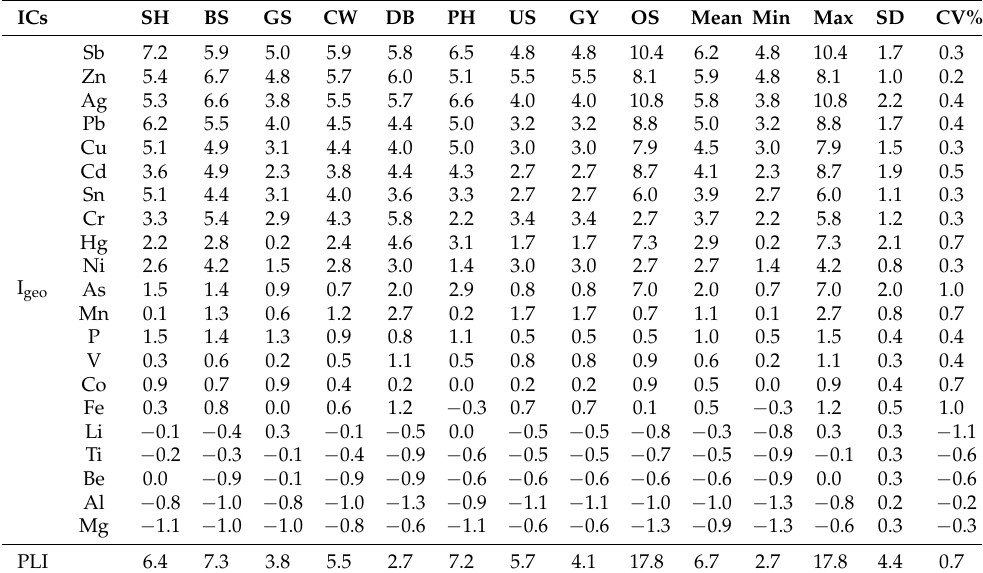
Table 5. Summary of the pollution levels of individual PTEs and the overall pollution level of various PTEs with I geo and PLI in nine industrial